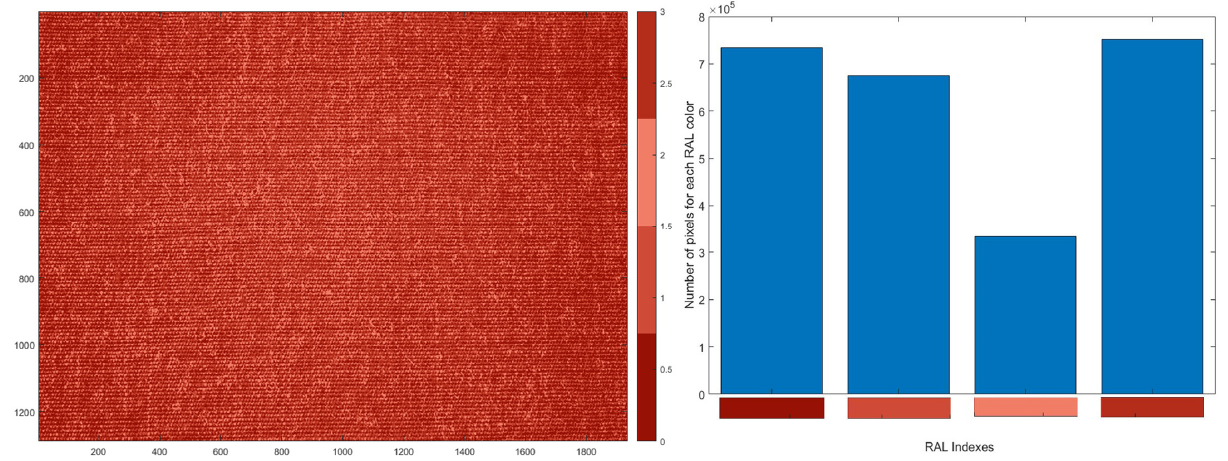
Figure 5. Indexed image and surface of the R channel for fabric with label 20/6/21.